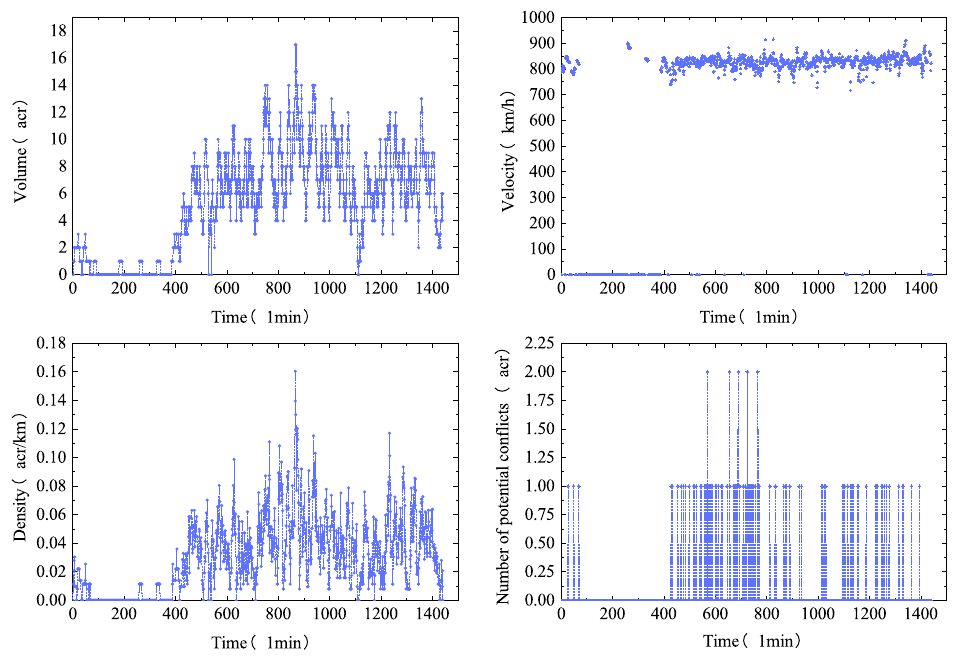
Figure 7. Statistical distribution of sector traffic